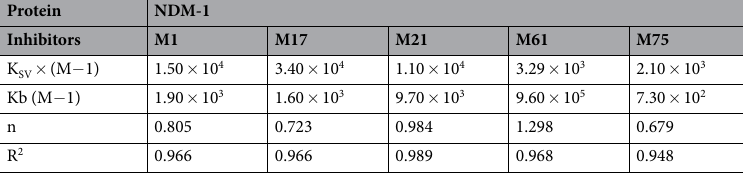
Table 7. Binding parameters obtained from Fluorescence Quenching Experiments.